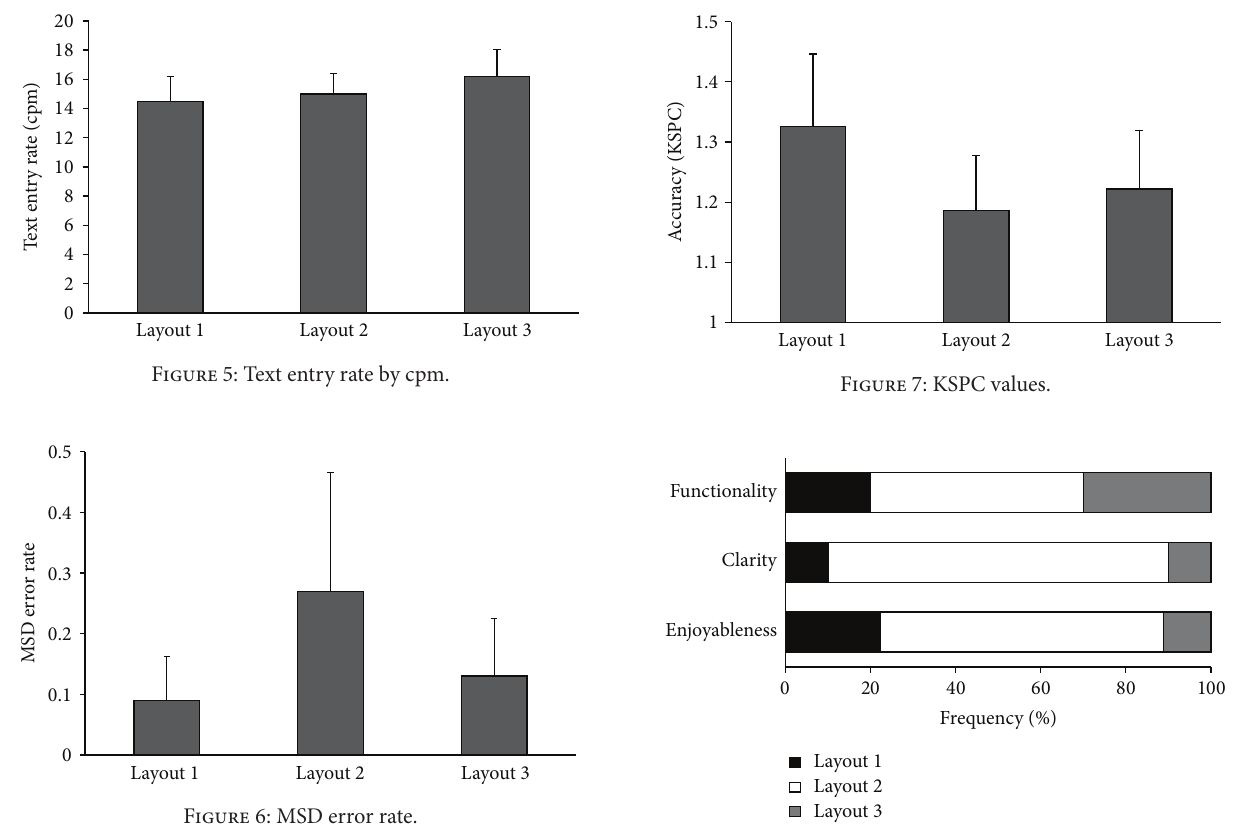
Figure 6: MSD error rate.